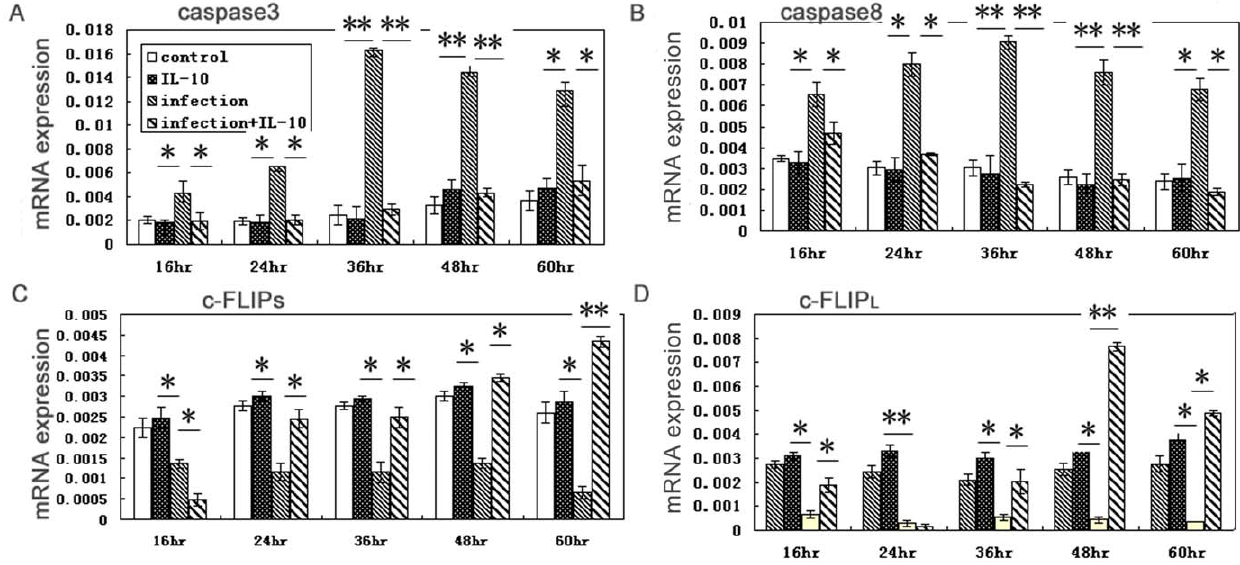
Figure 5. Changes in levels of mRNAs encoding caspase-3, caspase-8, c-FLIP L and c-FLIP S in BeWo cells due to infection are reverted upon IL-10 treatment. Caspase-3 (A) and caspase-8 (B) were both up-regulated while c-FLIP S (C) and c-FLIP L (D) were both down-regulated in infected cells compared to uninfected cells. Levels were reduced in infected cells treated with IL-10 compared to infected cells while no changes in treatment IL-10 in untreated cells relative to uninfected cells..IL-10 treatment solely modulates excessive-expression of apoptosis associated cells and no role in normal expression. * p , 0.05; ** p , 0.01.